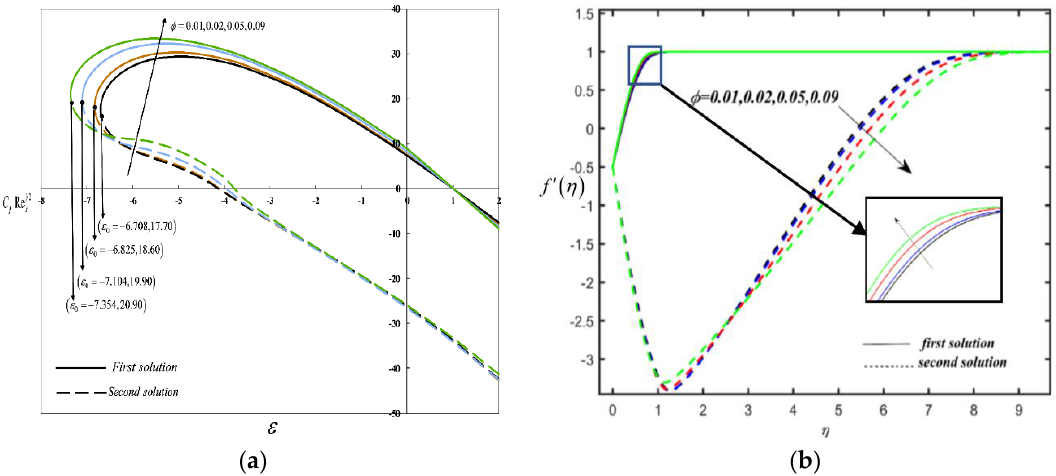
Figure 5. Impact of the nanoparticle volume fraction ( φ ) on: ( a ) the reduced skin friction coe ffi cient; ( b ) velocity profiles as φ varies when Rd = 1.2, m 0 = 1.5,Pr = 4.36, De = 1.5, s = 7, M = 0.5, and φ = 0.02. Table 3. The e ff ect of the radiation parameter ( Rd ) on the reduced local Nusselt number